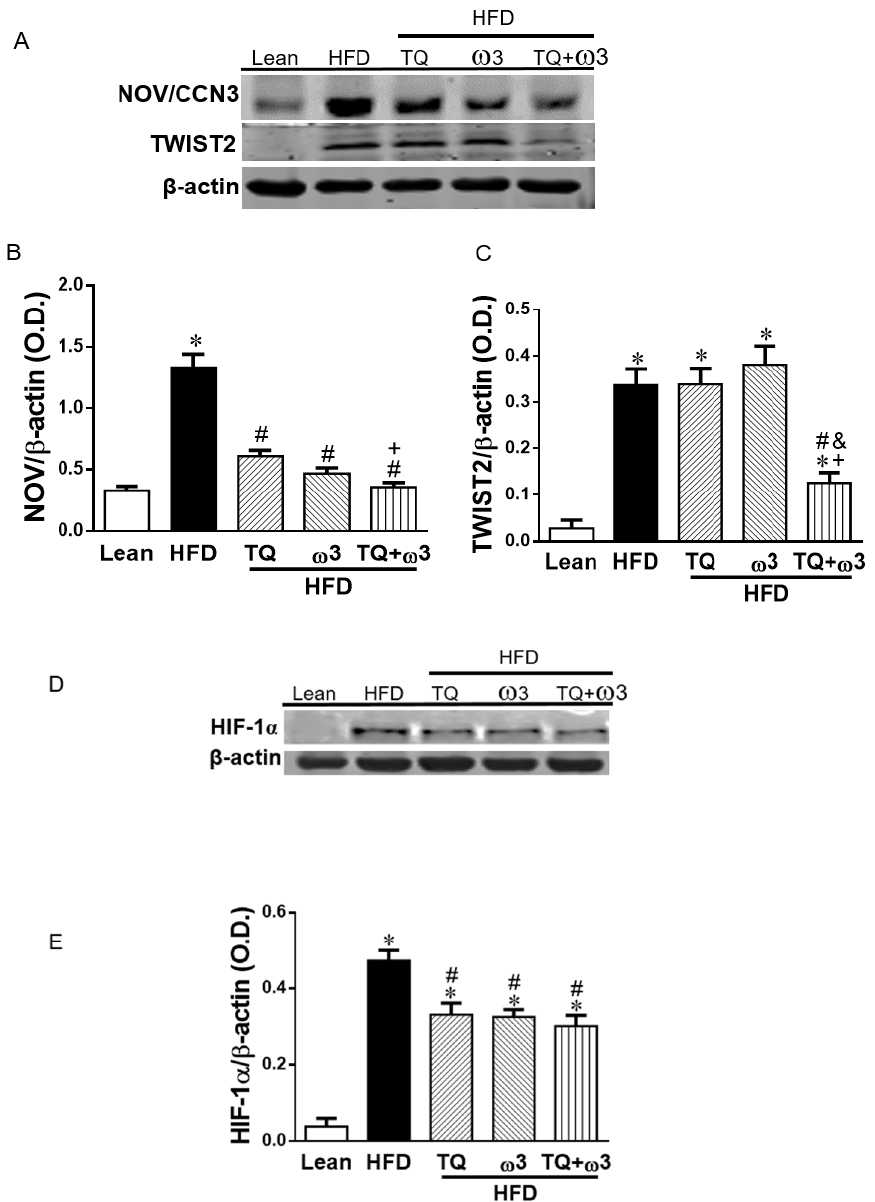
Figure 4. E ff ects of thymoquinone (TQ) and omega-3 ( ω 3) treatment on the inflammation and hypoxia in visceral adipose tissue of mice fed a high-fat diet (HFD). Representative Western blots ( A ) and densitometry analysis of Nephroblastoma Overexpressed (NOV / CCN3) ( B ) and Twist related protein 2 (TWIST2) ( C ); Representative densitometry analysis of hypoxia-inducible factor 1 α (HIF1 α ) ( D , E ). n = five animals per group. * p < 0.05 vs Lean; # p < 0.05 vs HFD, + p < 0.05 vs TQ, and & p < 0.05 vs ω 3.